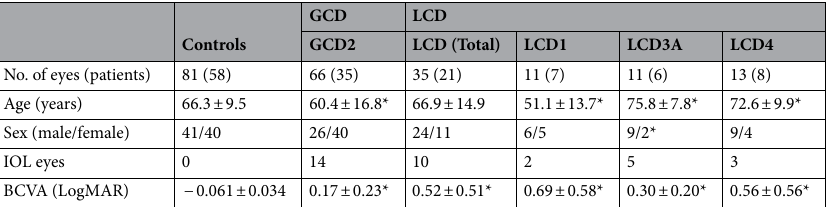
Table 1. Demographic characteristics of the participants. GCD : Granular corneal dystrophy, GCD1 : Granular corneal dystrophy type 1, GCD2 : Granular corneal dystrophy type 2, LCD : Lattice corneal dystrophy, LCD1 : deviation manner. p values were calculated using t-test or Fisher’s exact test, appropriately. *, shows the statically significant difference from the control.